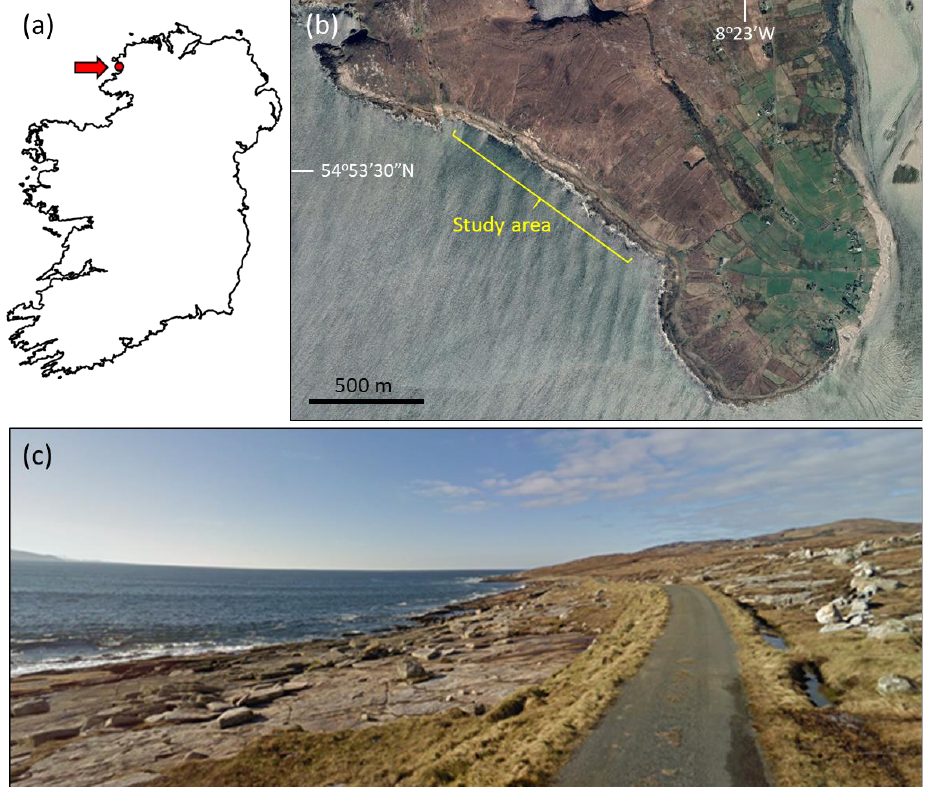
Figure 1. ( a ) The location of the study area in northwest Ireland, indicated by the red dot. ( b ) The study area is shown using satellite imagery. ( c ) A photo of the study area looking northwest. The surveyed area is located between the road and the sea and consists of a bedrock shore platform and boulders distributed on its surface.